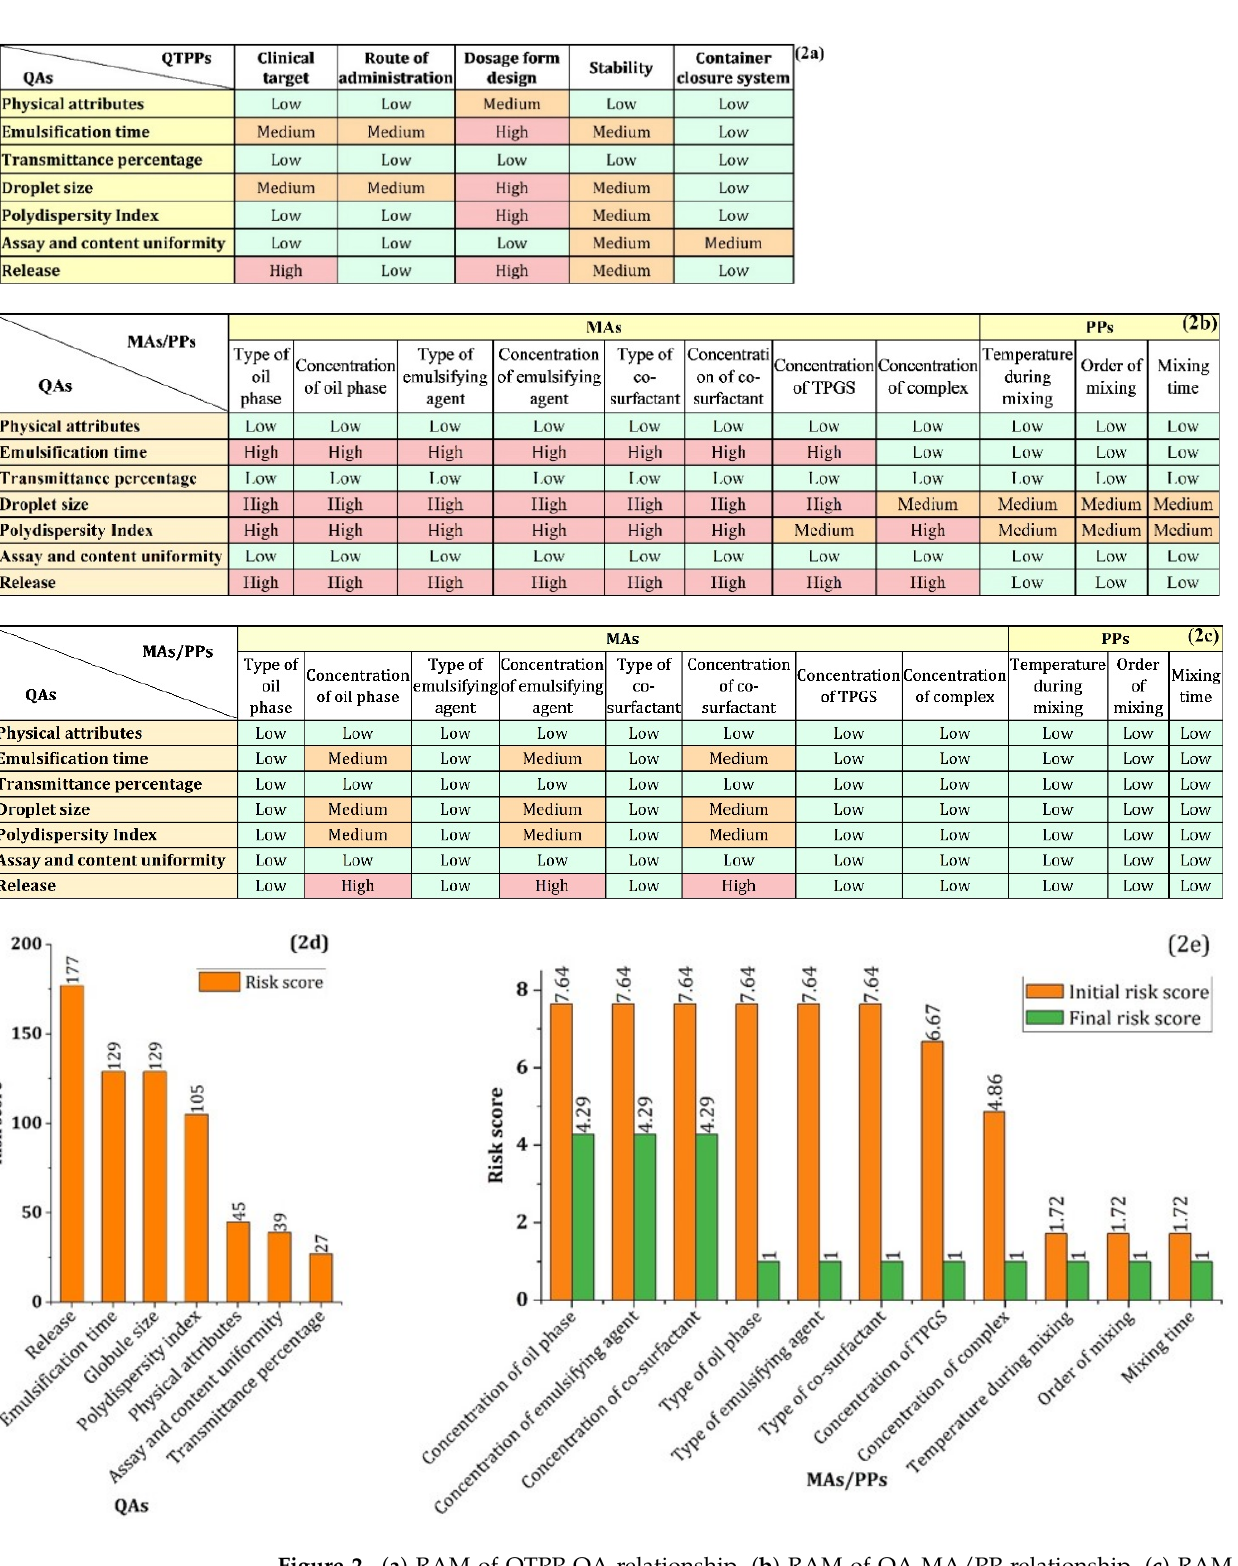
Figure 2. ( a ) RAM of QTPP-QA relationship, ( b ) RAM of QA-MA/PP relationship, ( c ) RAM of QA-MA/PP relationship after risk reduction, ( d ) risk score of QAs, and ( e ) risk score of MAs/PPs during initial risk analysis and after the risk reduction following the experimental approaches. From the RAM of QA-MA/PP, the final risk score of each MA/PP was obtained, ranging from 1.72 to 7.64 (Figure 2e). Based on the risk score, MAs/PPs were